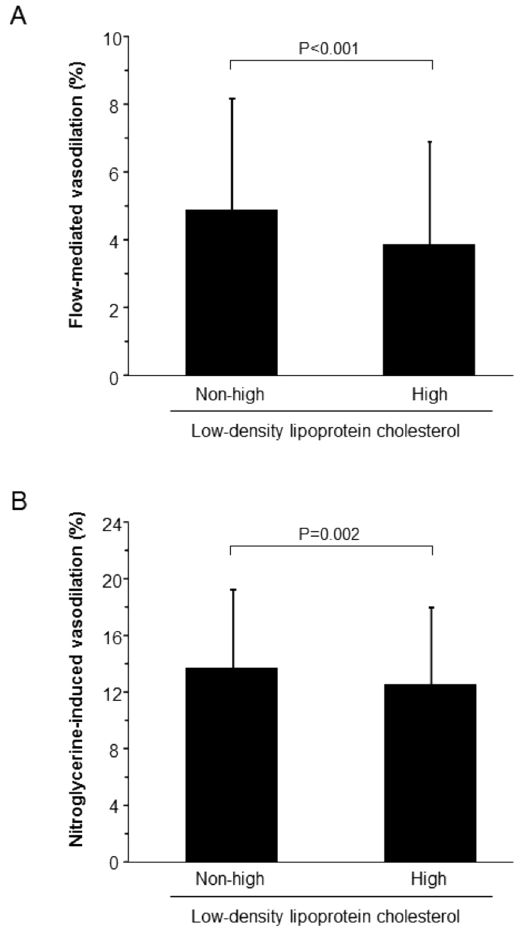
Figure 2. Scatter plots show the relationship between nitroglycerine-induced vasodilation and serum low- density lipoprotein cholesterol in all subjects ( A ), subjects not receiving statin therapy ( B ), and subjects receiving statin therapy ( C